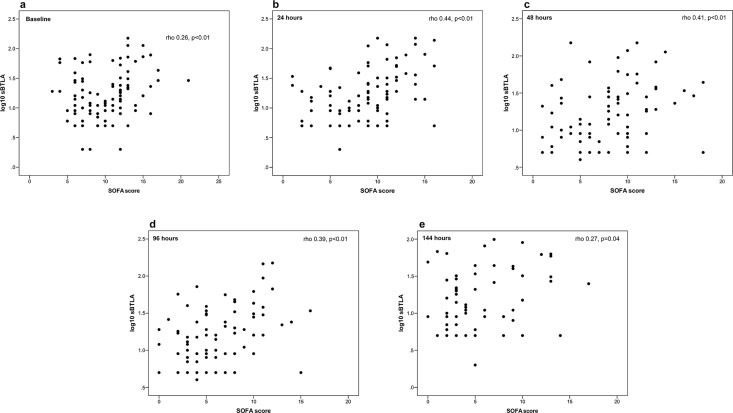
Correlation between sBTLA and SOFA score in sepsis patients.a) baseline b) 24 hours c) 48 hours d) 96 hours and e) 144 hours. sBTLA is presented on log10 scale due to non-Gaussian distribution.